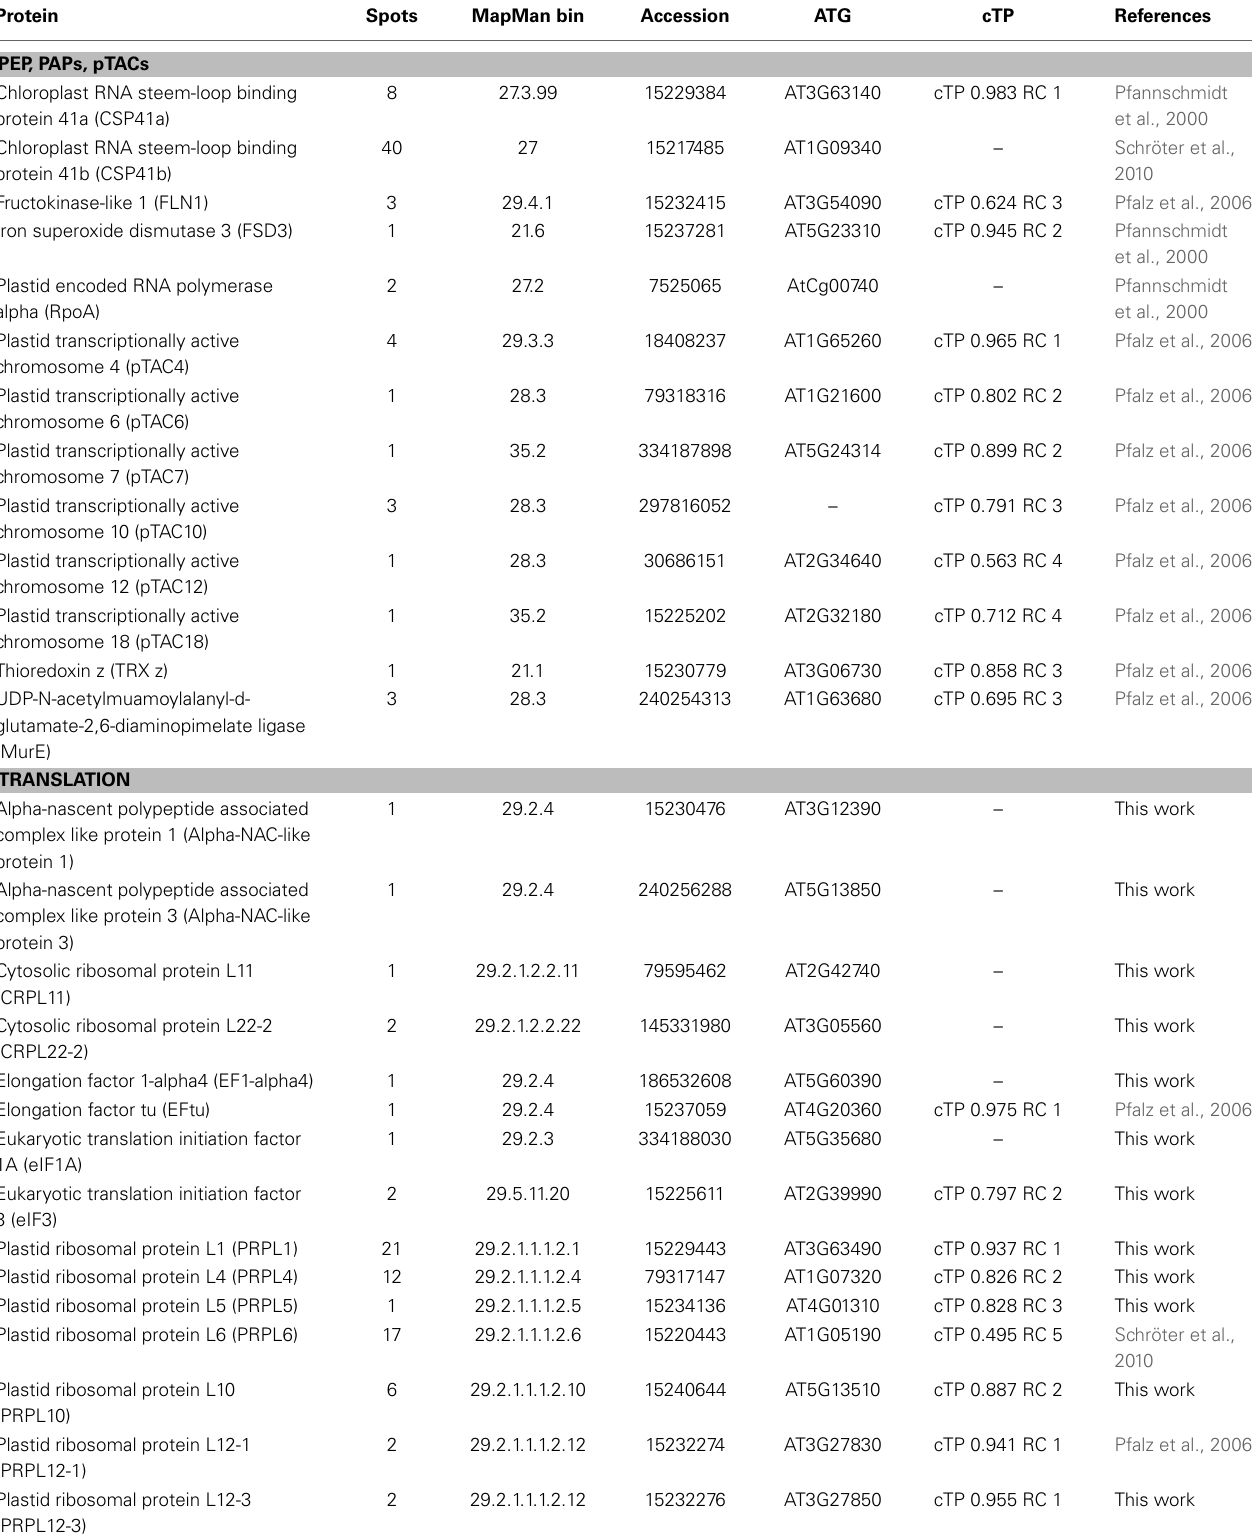
Table 1 | Functional categorization and characterization of proteins from the phosphocellulose fraction identified by LC-ESI-MS/MS.